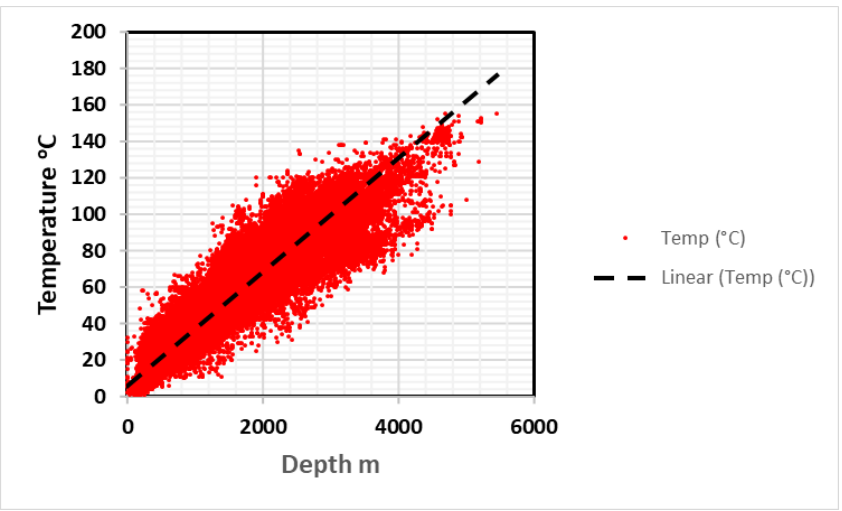
Figure 8. WCSB temperature records from (APP) Annual Pool Pressure test temperature data from shut-in wells. Linear approximation is: T (°C) = 0.031z + 5.58. Correlation coefficient is R = 0.96.